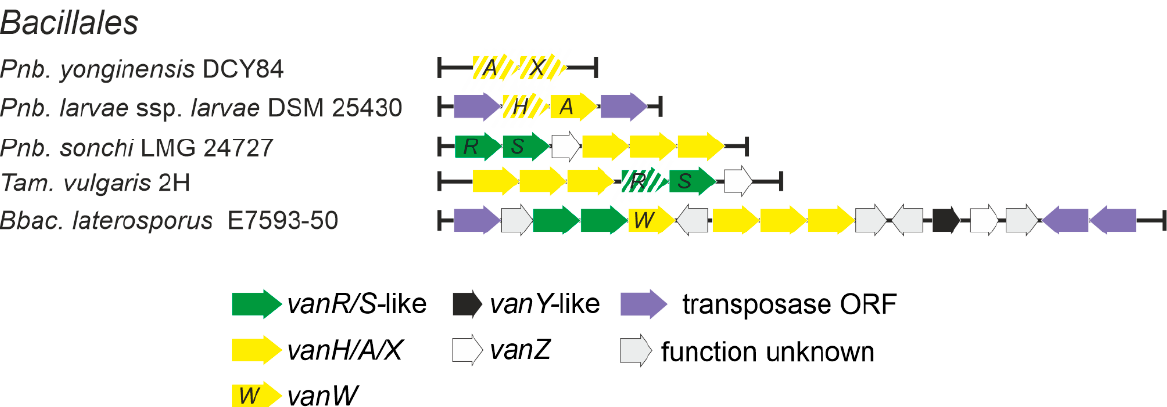
Figure 9. Arrangements of vlgs discovered in species belonging to Bacillales order. Please refer to the main text for more details; genus names were abbreviated according to ESM Table S1. The legend below the figure explains the color-coding of the scheme. Pseudogenes are shaded.